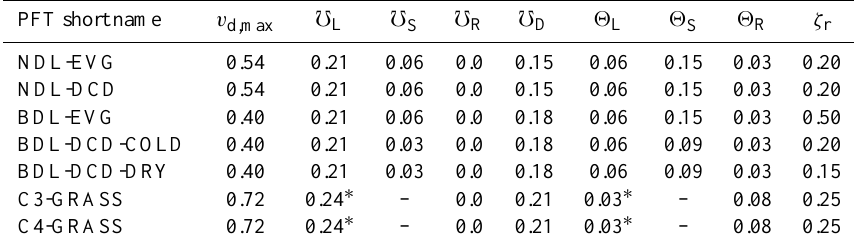
∗ For brown grass leaves